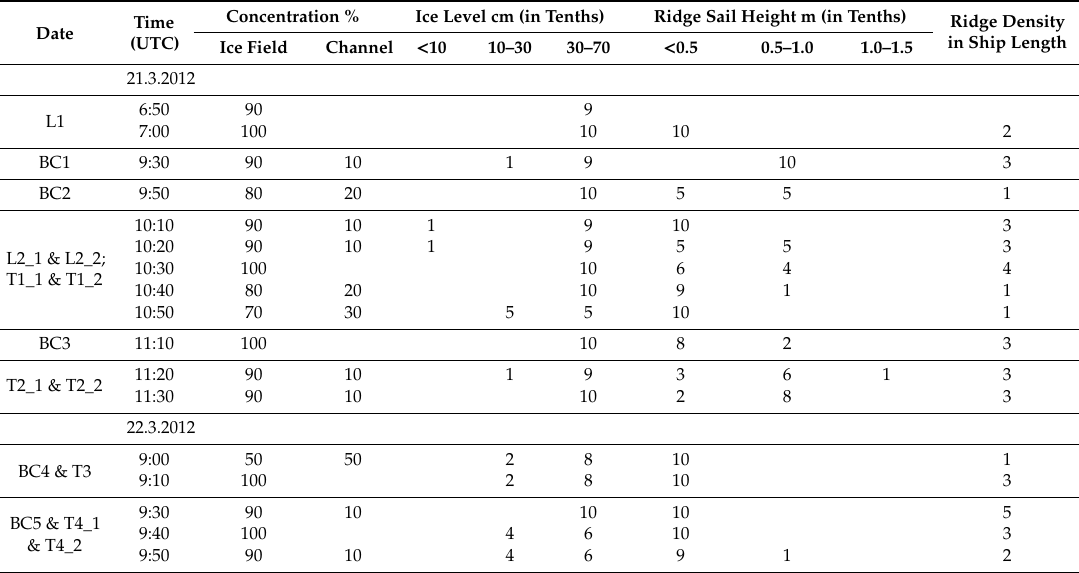
Table 3. Visual observations from the ice conditions during the tests. The time indicates the beginning of the